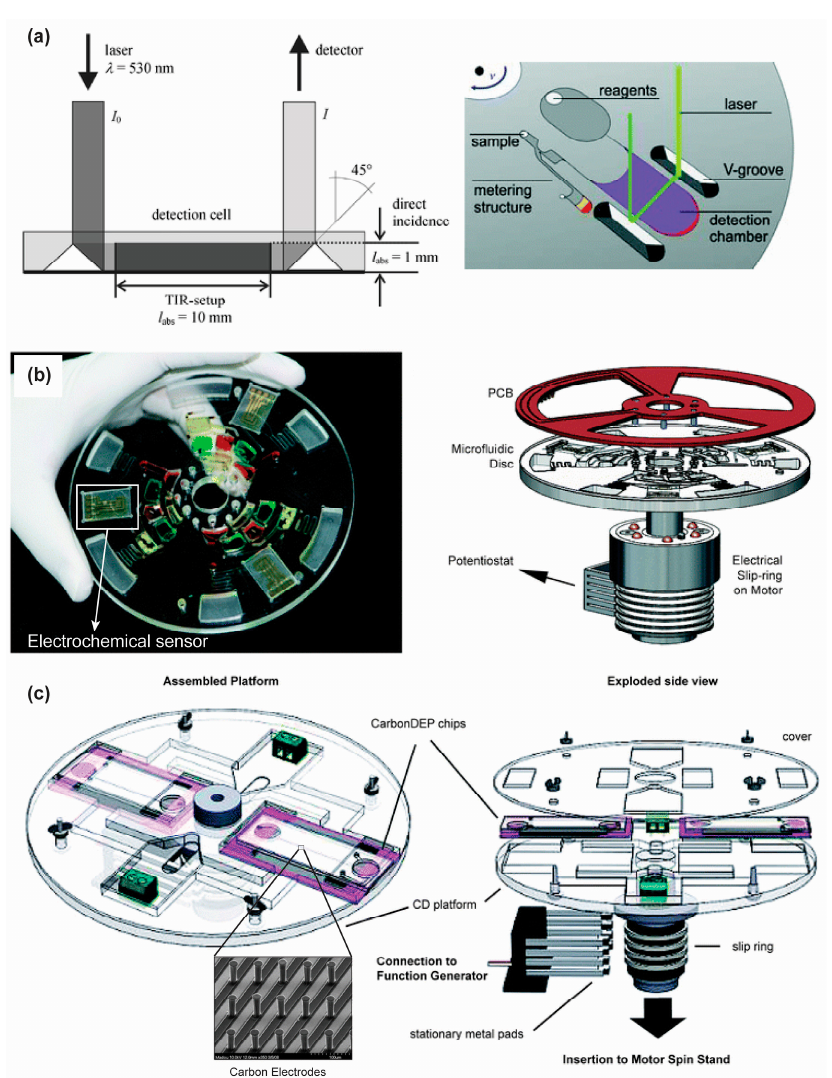
Figure 8. ( a ) Principle of absorbance detection adapted by Steigert and colleagues. Reprinted with permission from the Royal Society of Chemistry [92]; ( b ) Photograph of the CD device with the electrochemical sensor within it (left) and the schematic of the set up for electrochemical sensing. Reprinted with permission from the Royal Society of Chemistry [93]; ( c ) Experimental set up for 3D carbon electrode dielectrophoresis and schematic of the complete set up for electrical connection. Reprinted with permission from the Royal Society of Chemistry [94].